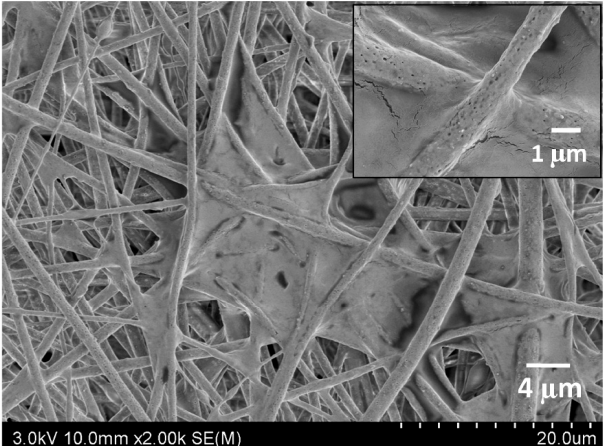
Figure 2. PLA / chitosan fibrous membrane for air purifier Figure 2. PLA/chitosan fibrous membrane for air purifier [19].